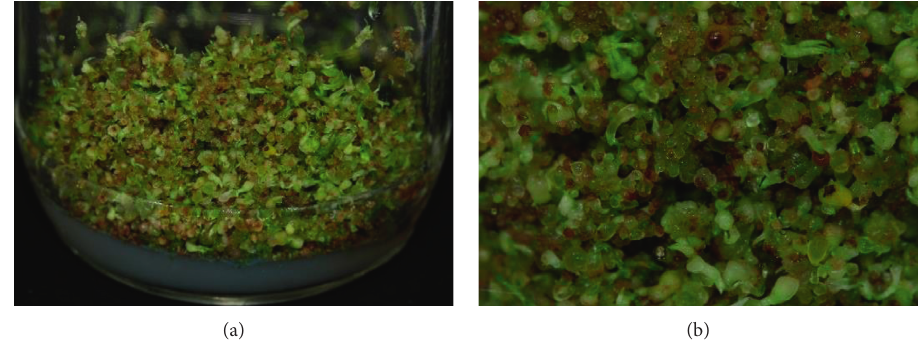
Figure 1: In vitro -developed protocorms from germinated immature seeds of D. chryseum cultured in 1/2 MS media after 4 months of primary culture. Cultures were maintained under fluorescent light with 8h dark and 16h light at 25 ° C and six replicates were used for each